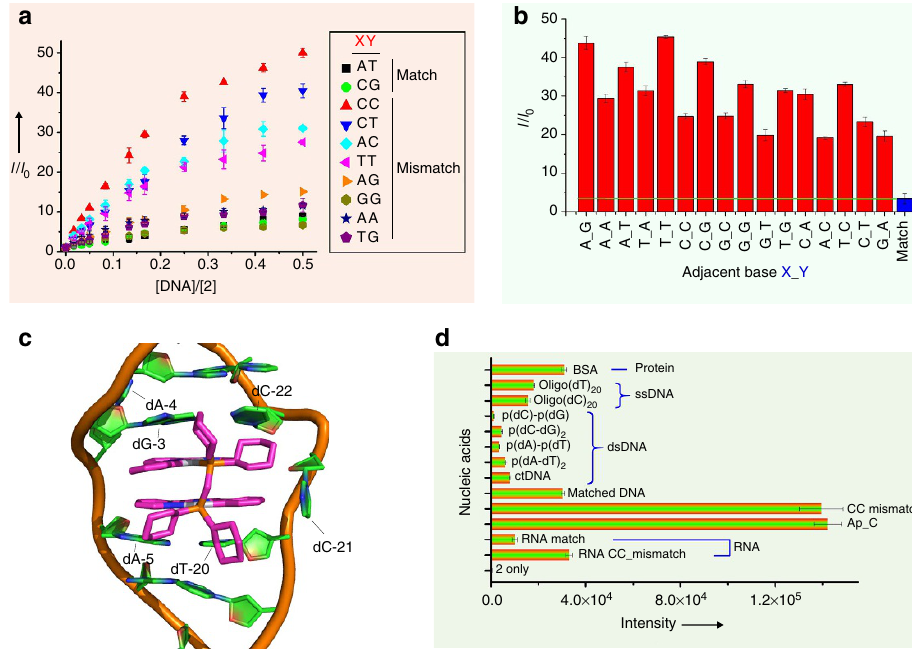
Figure 5 | Binding of 2 with mismatched DNA. ( a ) Changes in emission intensity ( ± s.e.m.) at 634nm of 2 (5 m M) in Tris buffer solution (50mM NaCl, 2mM Tris, pH 7.5) after the addition of different concentrations of various DNA. ( b ) Relative emission enhancement of 2 towards CC mismatched DNA with different adjacent base pairs. ( c ) QM/MM optimized structure of mismatched DNA bound to 2 . ( d ) Emission responses (intensity ± s.e.m.) of 2 towards different